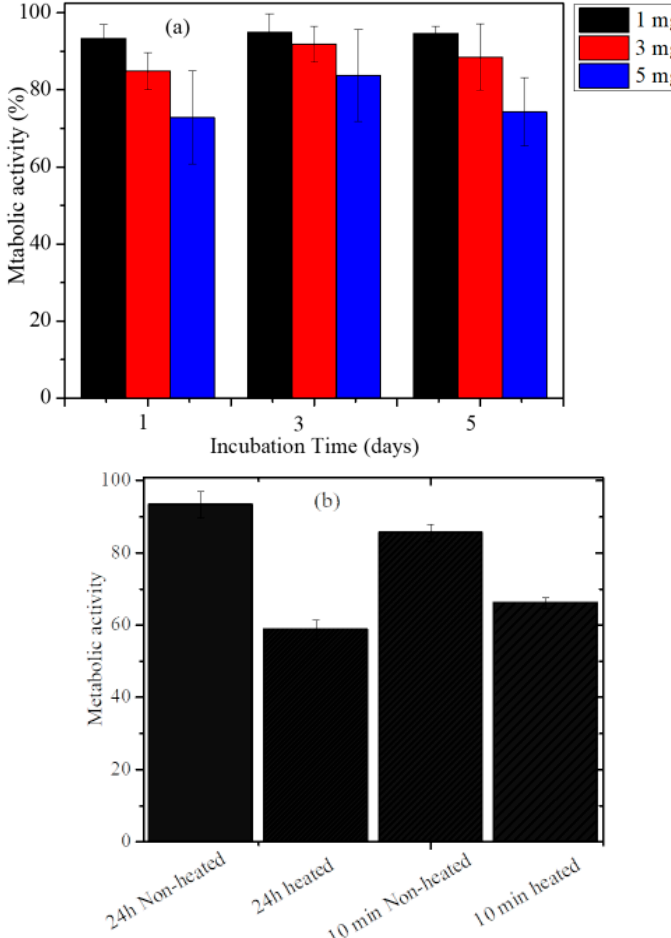
Figure 6. ( a ) MTT assay of HeLa and ( b ) HeLa cells treated with GO-Fe 3 O 4 nanocomposite and subjected to an AC magnetic